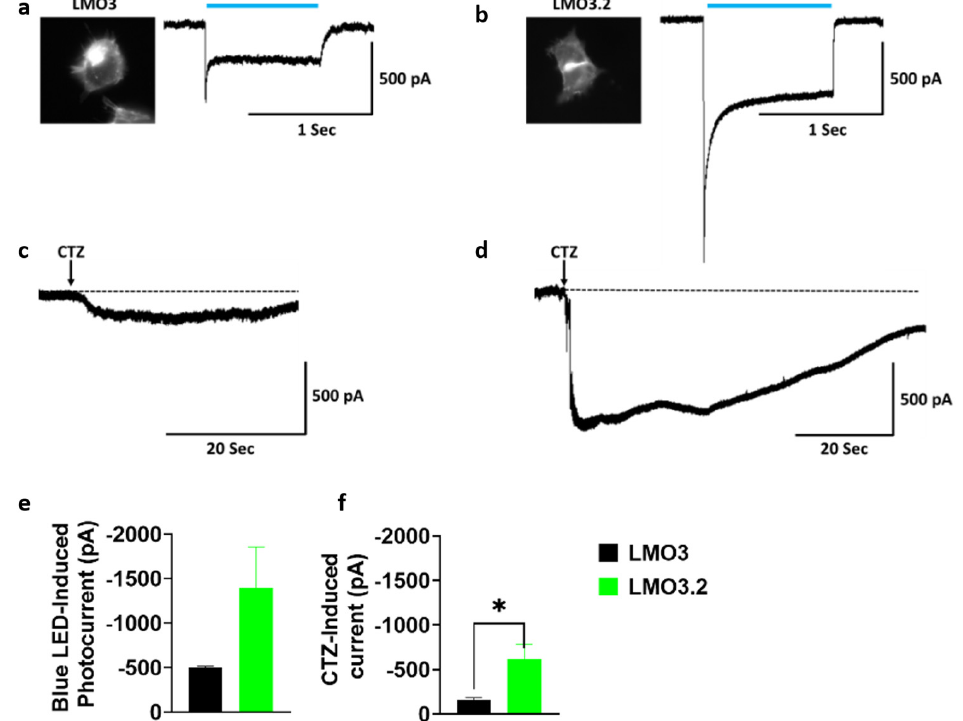
Figure 2. Comparison of LMO3 and LMO3.2 activation using blue light and CTZ. ( a ) Left, EYFP fluorescence in HEK cells expressing LMO3. Right, representative photocurrent after blue light stimulation. ( b ) Left, EGFP fluorescence in transiently lipofected HEK cells expressing LMO3.2. Right, representative photocurrent after blue light stimulation. ( c ) Representative photocurrent after activation of VChR1 based LMO3 via CTZ-induced bioluminescence emission from sbGLuc. ( d ) Representative photocurrent after activation of CheRiff based LMO3.2 via CTZ-induced bioluminescence emission from sbGLuc. ( e ) Blue light induces a greater photocurrent in LMO3.2-expressing cells than LMO3. ( f ) CTZ induced bioluminescence results in a significantly greater photocurrent in LMO3.2-expressing cells than LMO3; * p < 0.05 versus LMO3 (Student’s t test). Error bars indicate SEM; n = 3 cells